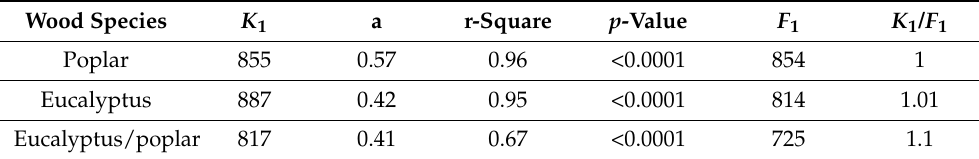
Table 3. Constants K 1 , r 2 and p values in the prediction equation for the average maximum with- drawal loads of one-row multi-stapled joints composed of three different plywood types.